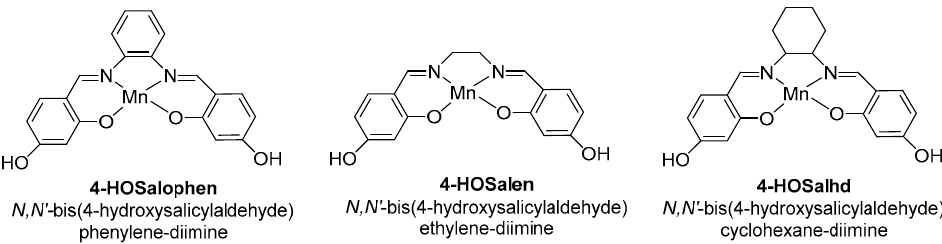
Scheme 7. Structure of various Mn(Salen) complexes (adapted from reference [37]).